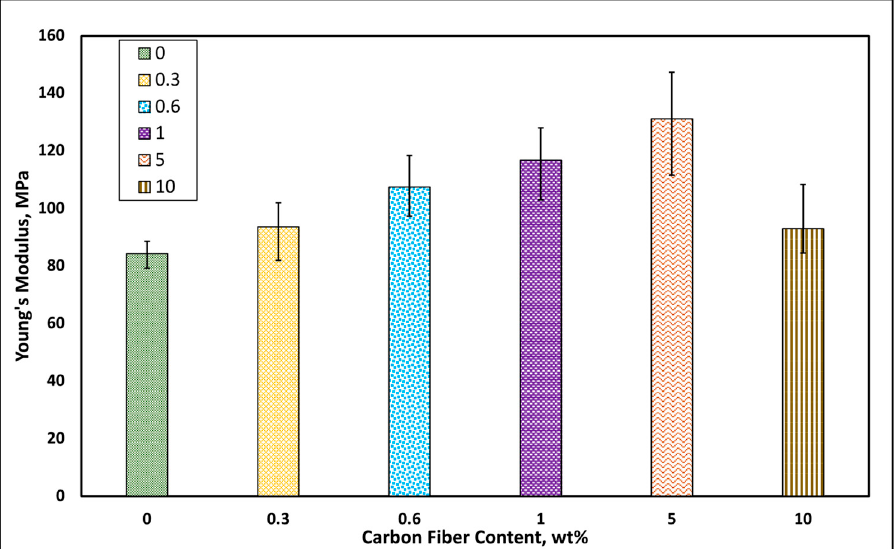
Figure 4. E ff ect of carbon fi ber content in SLS-Printed fully cured thermose tt ing samples on Young’s Figure 4. Effect of carbon fiber content in SLS-Printed fully cured thermosetting samples on Modulus. Young’s